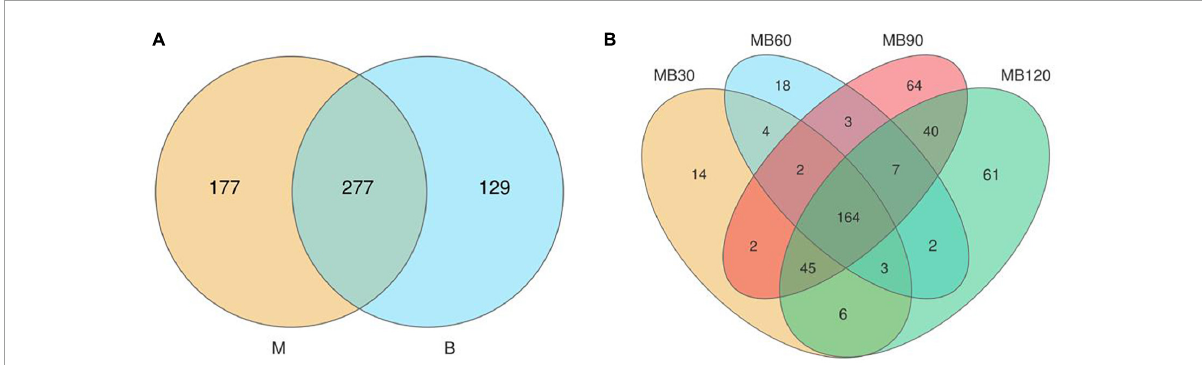
FIGURE2 (A) Diagram of bacterial OTUs of fresh materials. (B) Venn diagram of bacterial OTUs of silage. M, maize; B, faba bean; MB30, 30 days of mixed silage of maize and faba bean; MB60, 60 days of mixed silage of maize and faba bean; MB90, 90 days of mixed silage of maize and faba bean; MB120, 120 days of mixed silage of maize and faba bean.